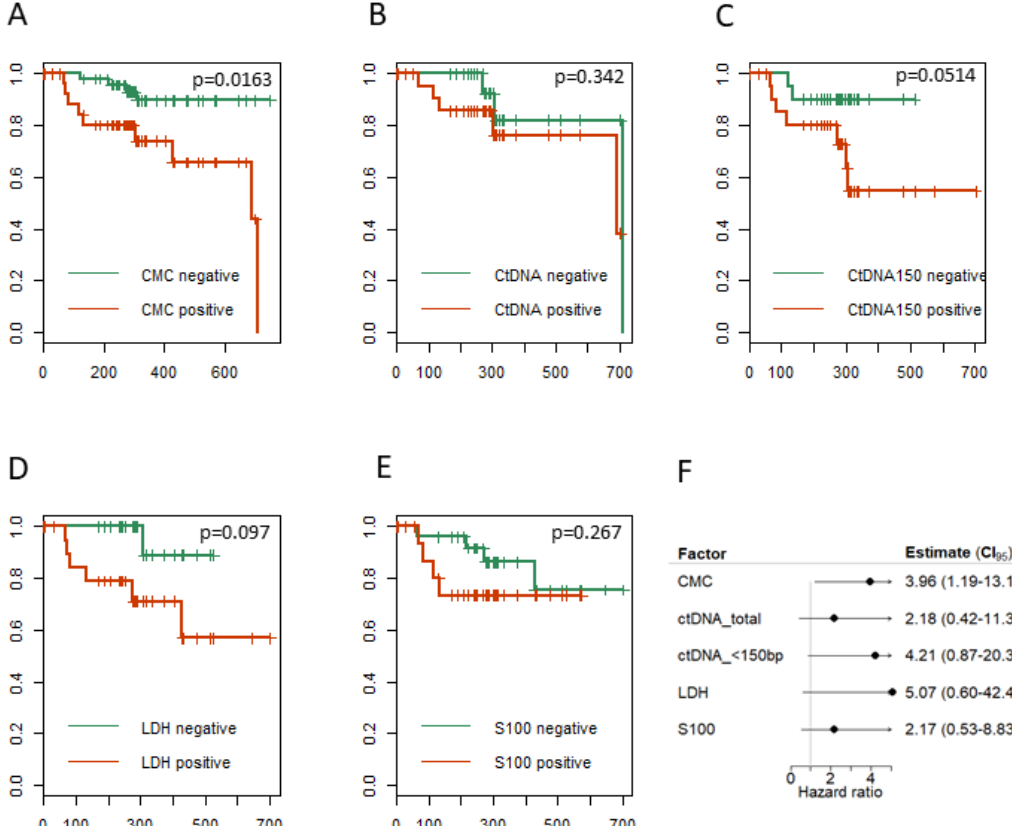
Figure 5. Prognostic value of liquid biopsy markers ( A – E ) Kaplan–Meier curves for each marker in the tested melanoma patient cohort. ( F ) Hazard ratio.